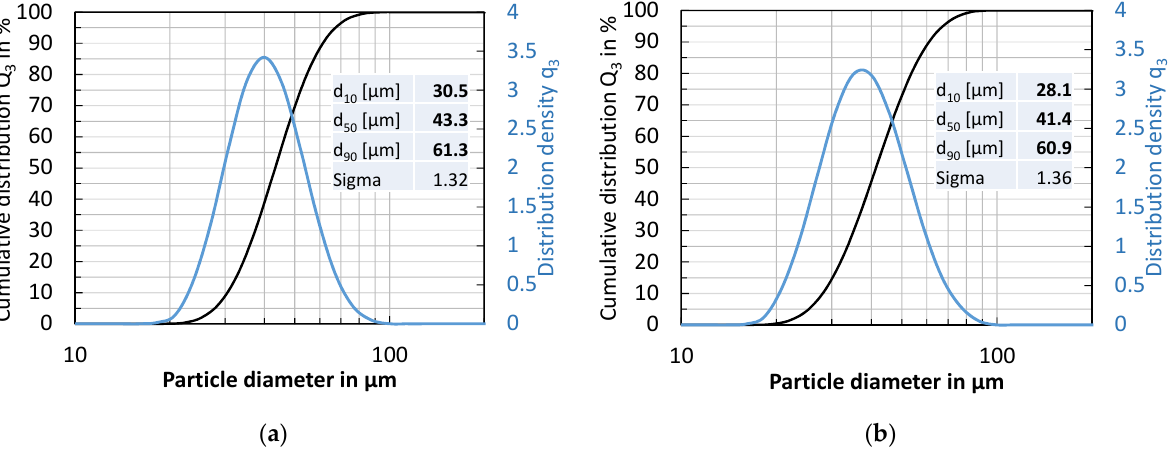
Figure 4. Particle size distribution of the initial powders: ( a ) X2CrNiMo17 ‐ 12 ‐ 2; ( b ) X2CrNiMoN25 ‐ 7 ‐ 4.